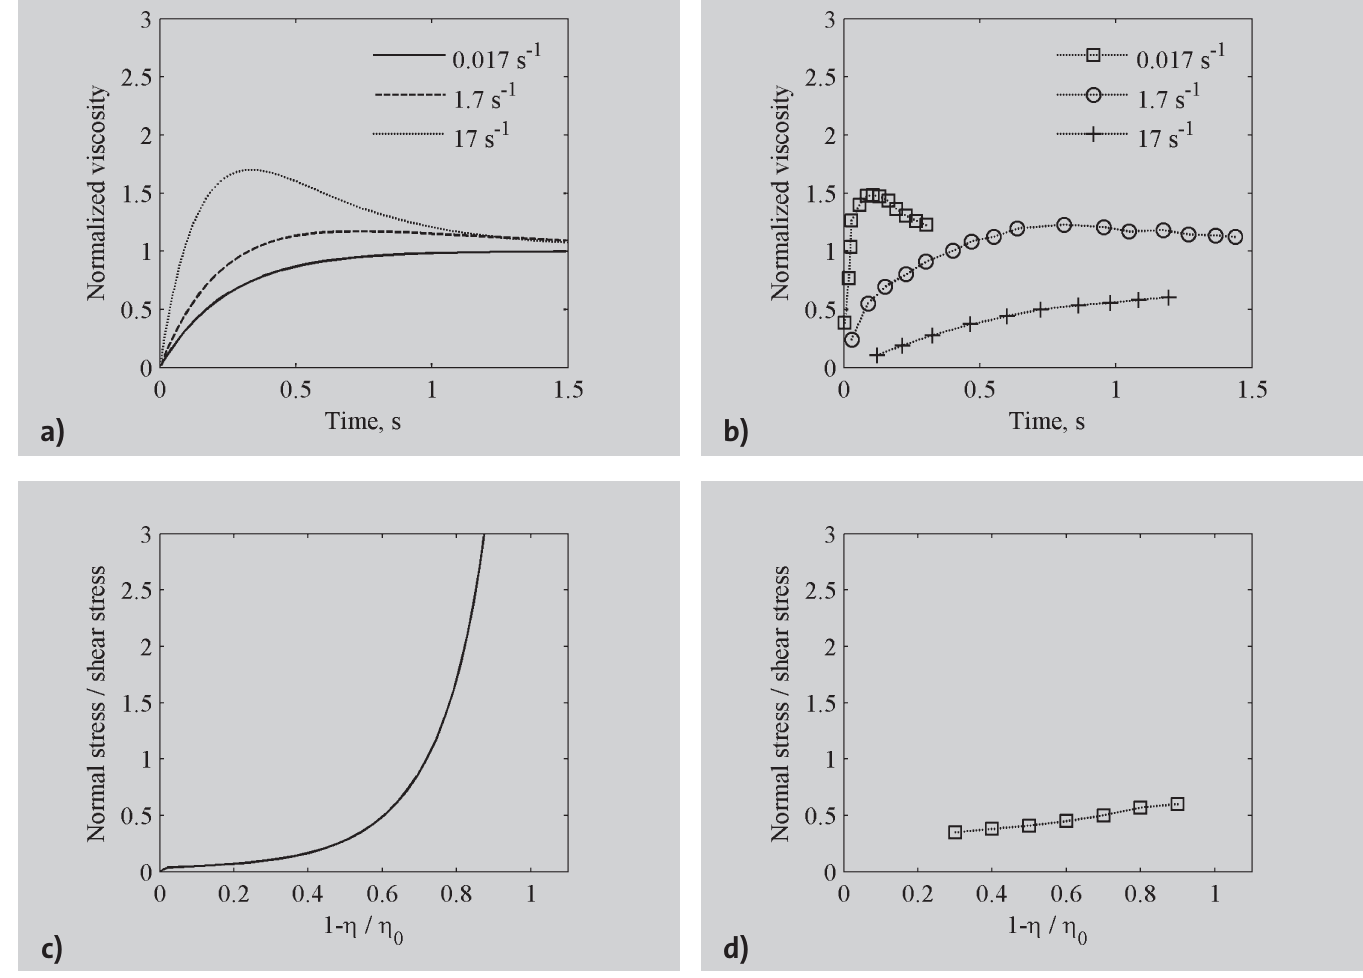
Figure 7: (a) Comparison of stress growth (normalized viscosi- ty defined as the ratio of viscosity at any time and steady viscosity at a given shear rate), the model results. (b) Experimental data trends corresponding to Figure 7a [6]. (c) Variation of the normal stress to shear stress ratio for the same asphalt as Figures 7a and 7b, the model result, (d) Experimental data trends corresponding to Figure 7c